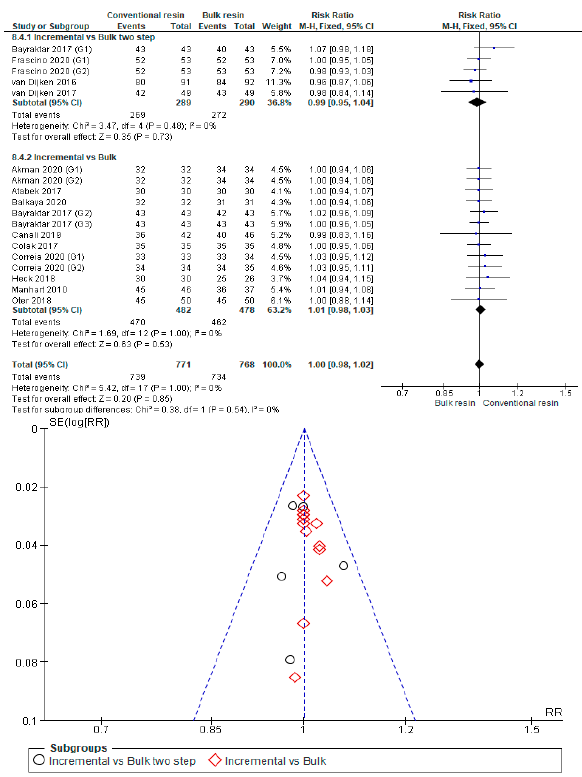
Figure A37. Proper Anatomical Form: Conventional Resin versus Bulk Resin According to Type of Teething.